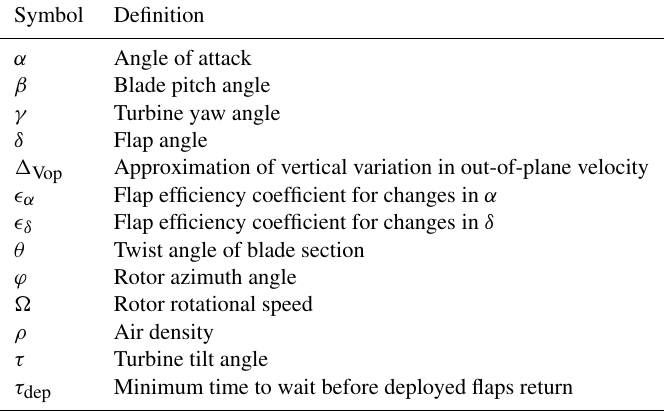
Table B2. List of Greek symbols used in this paper.